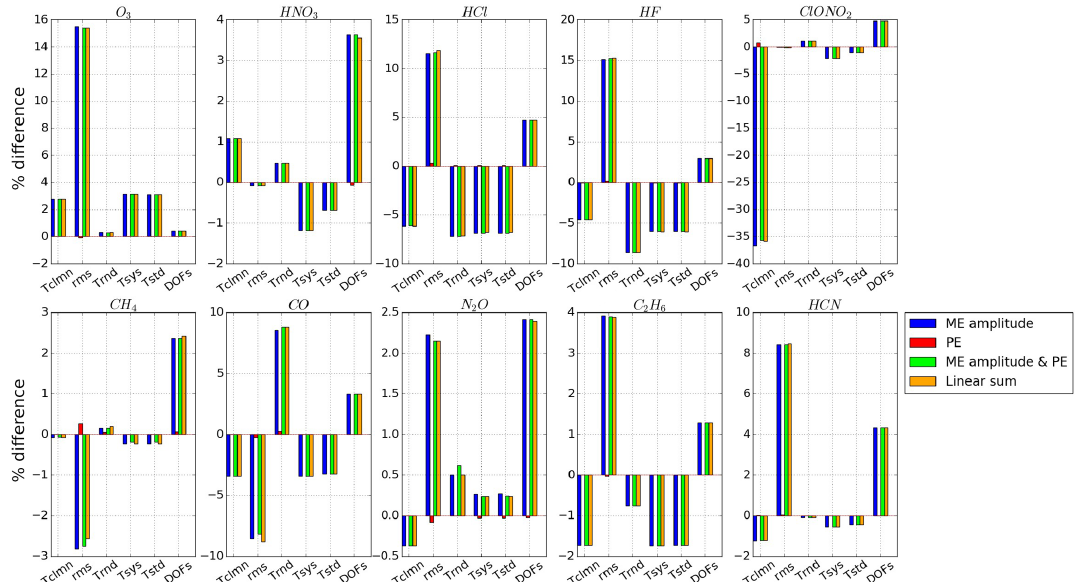
Figure 6. Fractional difference in the total column, the rms, the total random uncertainty, the total systematic uncertainty, the total uncertainty, and DOFs for misalignment j. “ME amplitude” represents the ILS which only took ME amplitude deviation into account. “PE” represents the ILS which only took PE deviation into account. “ME amplitude & PE” represents the ILS which took both the ME amplitude and PE deviations into account. The fractional difference of each item is the “linear sum” of the ME amplitude and PE. The ME amplitude and PE are obtained from ALIGN60 with misalignment j in Fig. 1. The results are deduced from the spectra recorded at Hefei on 16 February 2016.